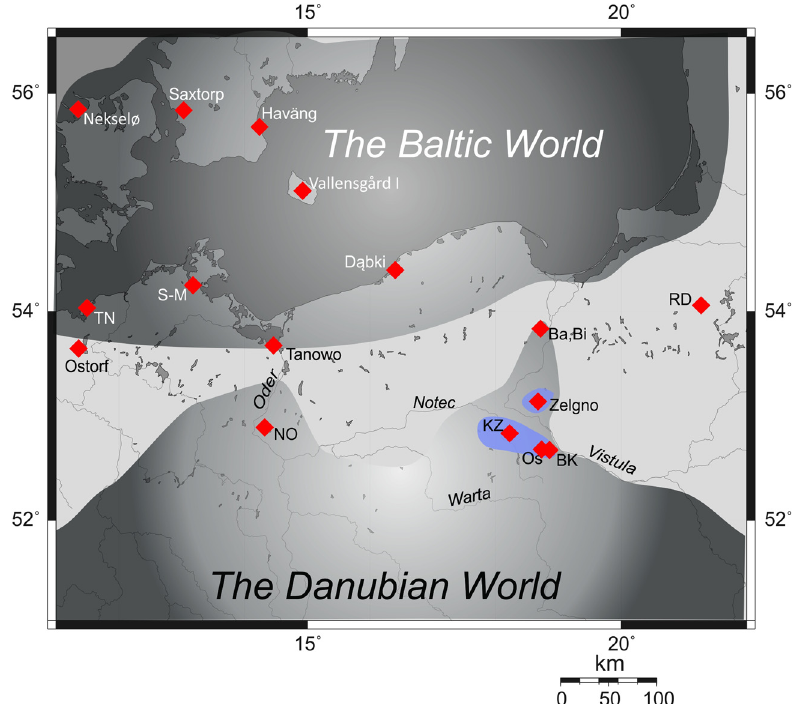
Figure 1: The Danubian and the Baltic Worlds during the fi fth millennium BC with sites mentioned in the text. Key to abbre - viations: Ba – Bar ł o ż no; Bi – Bielawki; BK – Brze ść Kujawski; KZ – Krusza Zamkowa; NO – Nowe Objezierze; Os – Os ł